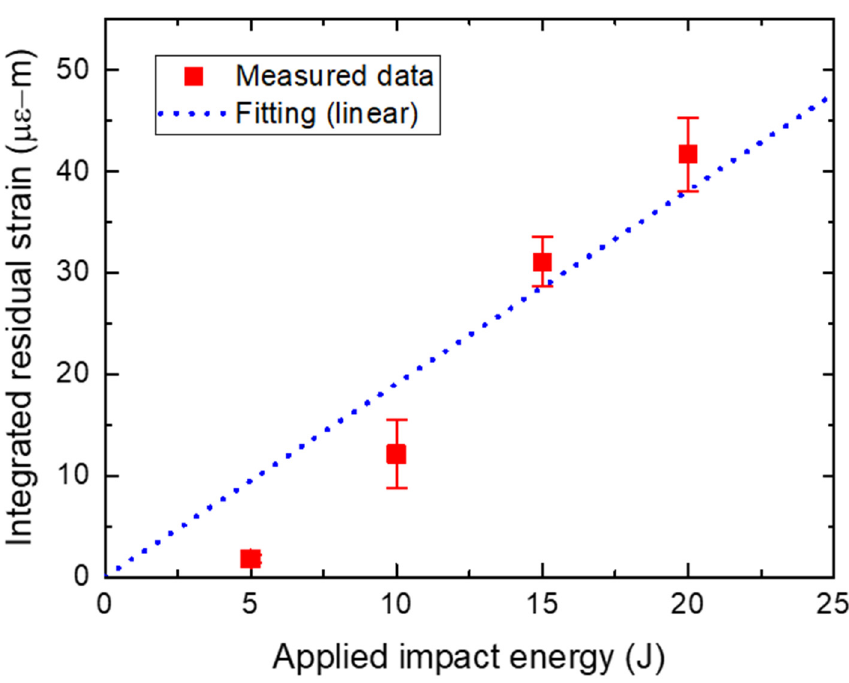
Figure 9. The integrated residual strain according to the applied impact energy.